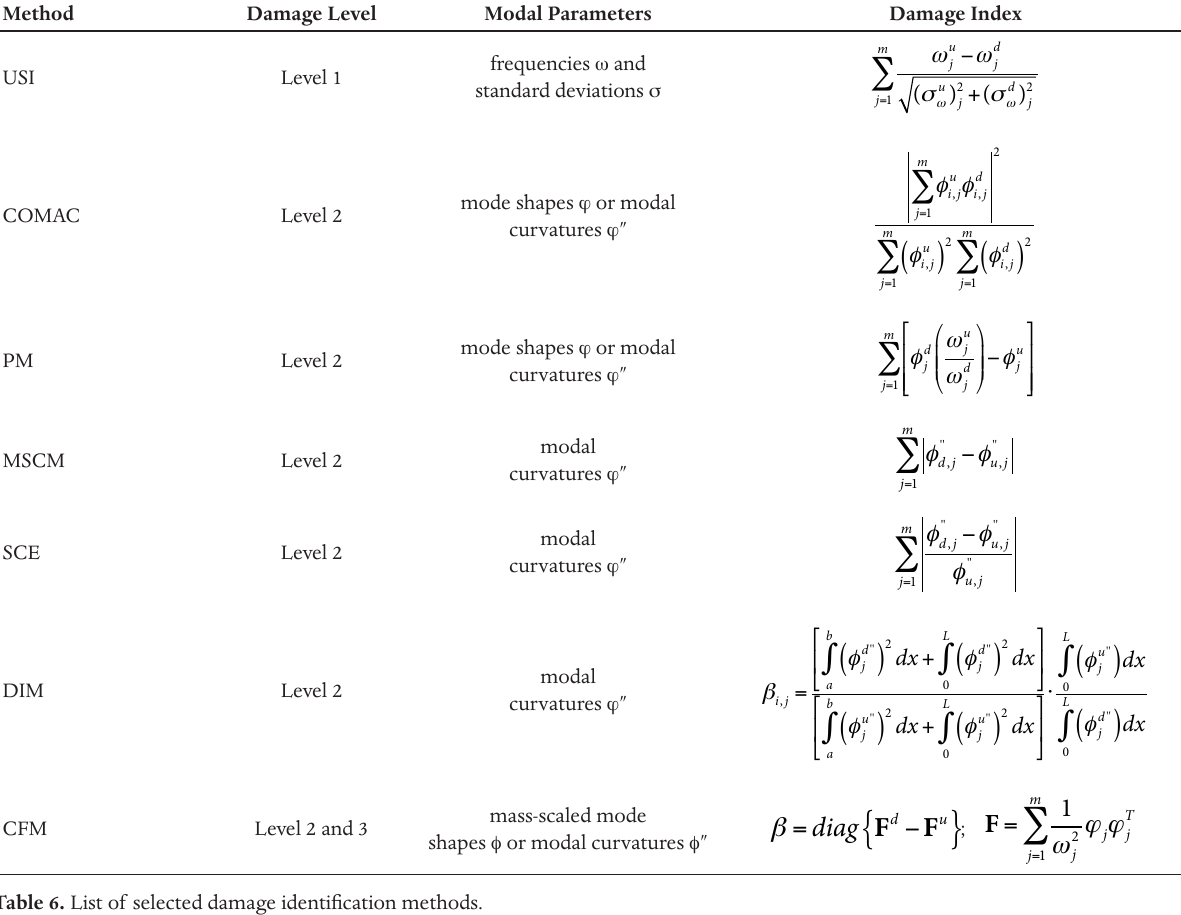
Table 6. List of selected damage identification methods.